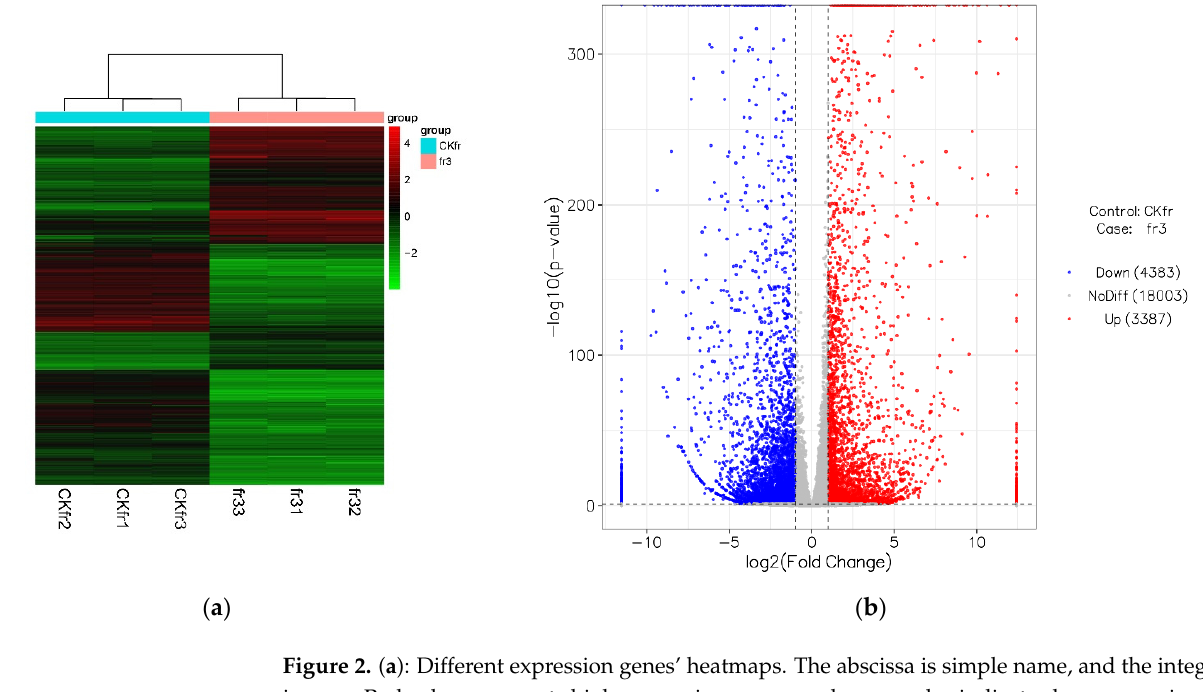
Figure 2. ( a ): Different expression genes’ heatmaps. The abscissa is simple name, and the integration is gene. Red color represents high expression genes, and green color indicates low expression genes; ( b ): different expression genes volcano map. The abscissa is log2foldchange, and the integration is − log10 ( p -value). The two vertical dashed lines in the figure are 2 times expressed difference threshold, the transverse line is a p -value = 0.05 threshold. The red color dot indicates that the group is up-regulated, the blue color dot indicates that the group is reduced, and the ash represents a non-significant difference expression gene.